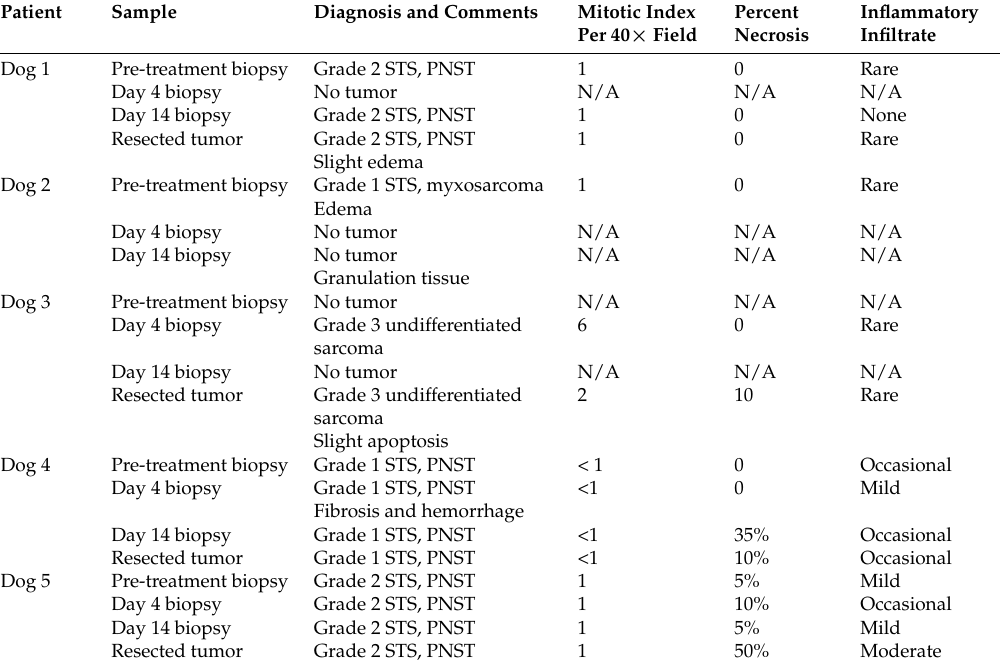
Table 3. Histology findings in dogs treated with 10 6 plaque-forming units of MYXV ∆ serp2 intratumorally.